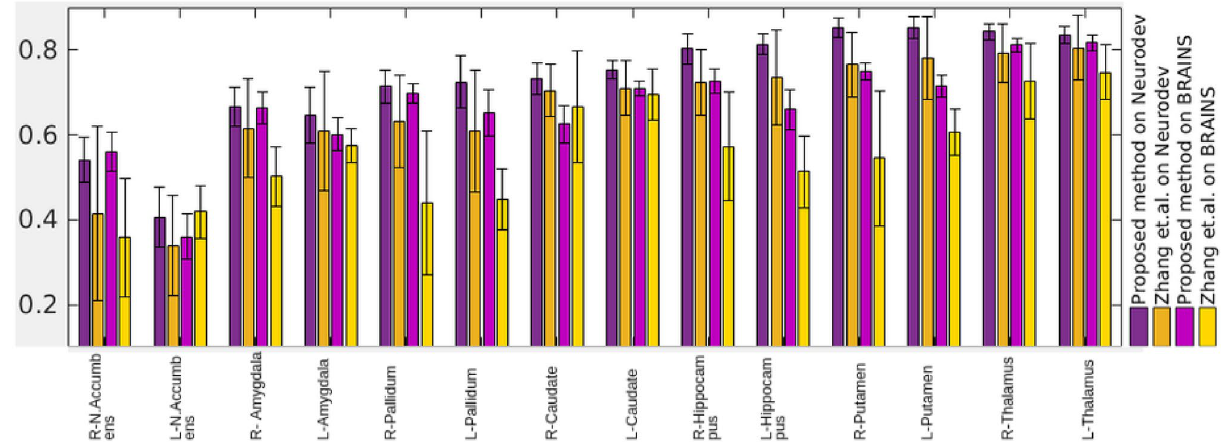
Figure 10. A comparison between performance of the proposed method and Zhang et al. 29 with Neurodev 24 and BRAINS 27 datasets. Dice scores are plotted for various